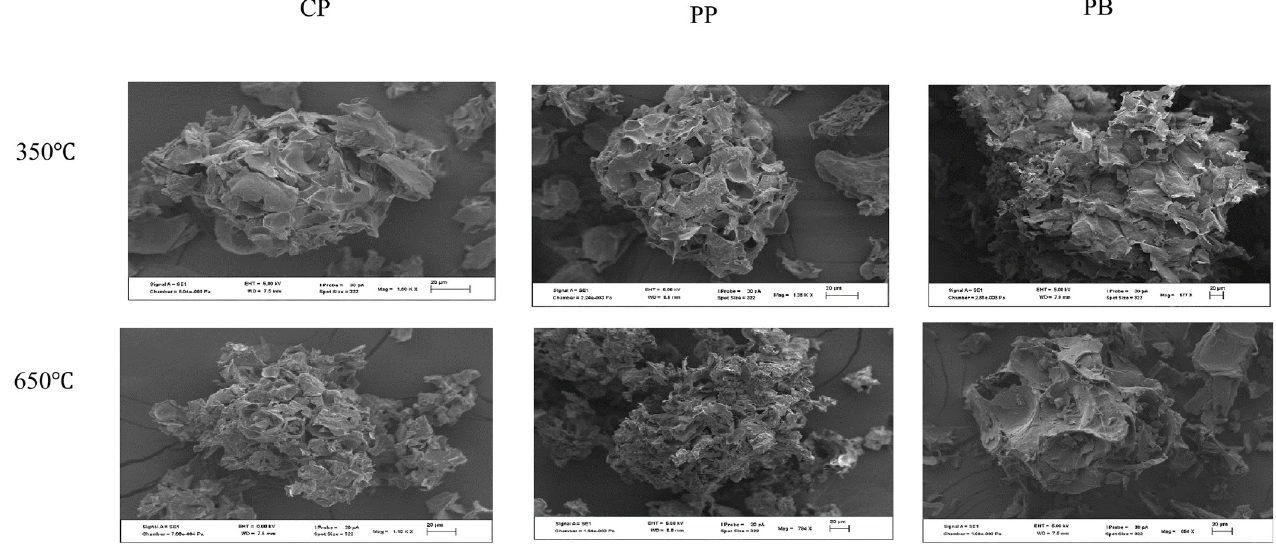
Fig 2. Morphological comparison of 6 studied biochars at different pyrolysis temperature using Scanning Electron Microscopy. CP = cull potato waste; PP = Peel potato waste; PB = pine bark.